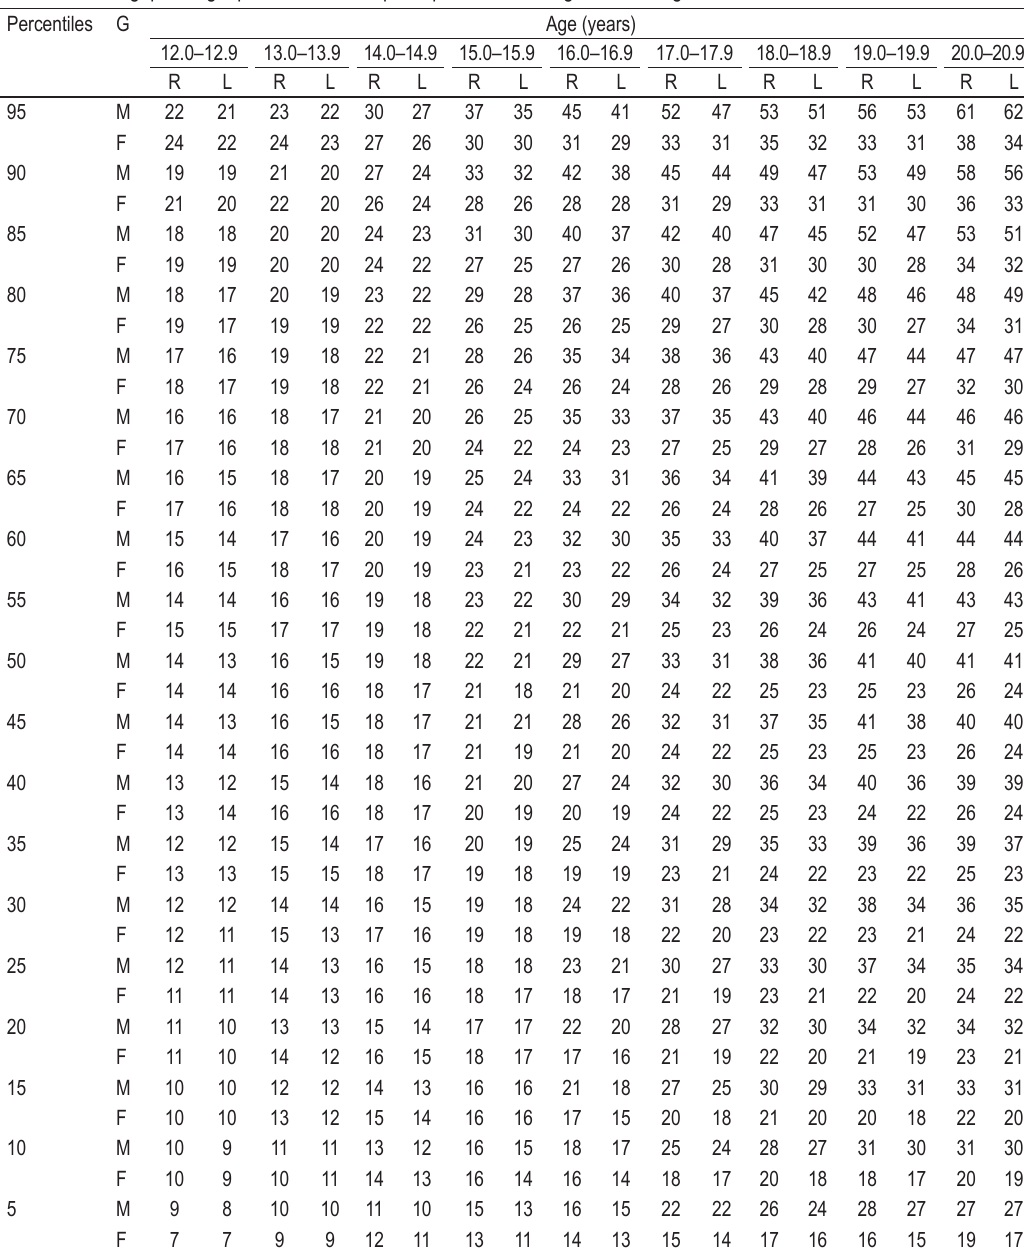
TABLE 2. Handgrip strength percentiles of the participants based on gender and age Percentiles G Age